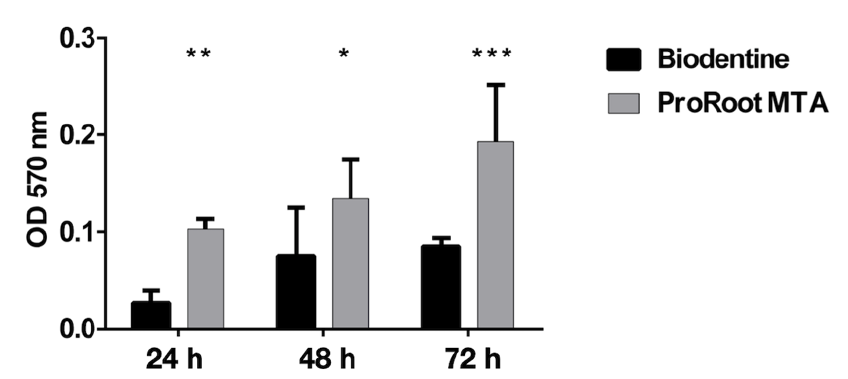
Figure 6. Analysis of cell viability, measured by the thiazolyl blue tetrazolium bromide (MTT) assay, of Saos-2 cells grown on Biodentine and ProRoot MTA disks for 24, 48, and 72 h. Data are expressed as mean ± SD. Statistical analysis was performed by the two-way analysis of variance (ANOVA) method coupled with the Bonferroni post-test (*** p < 0.001, ** p < 0.01, * p <